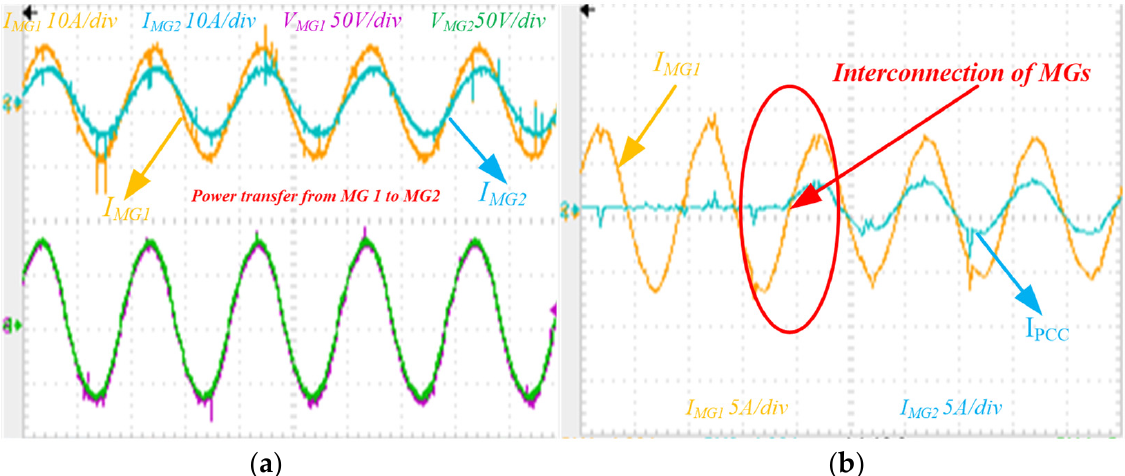
Figure 14. Power transfer between the CMGs. ( a ) Generated load current in CMG1 and CMG2 and ( b ) power transfer from CMG1 to CMG2.